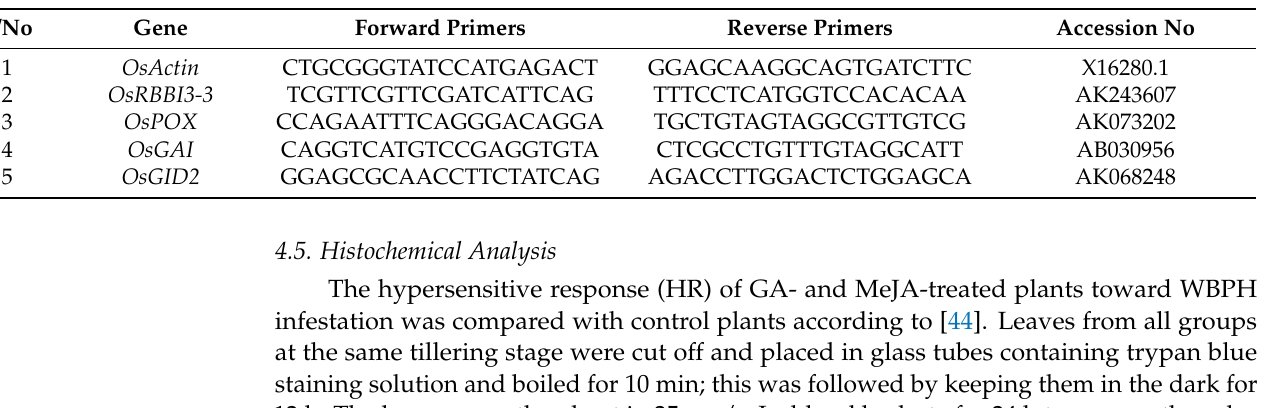
Table 3. Primers and accession numbers of selected genes designed by NCBI for